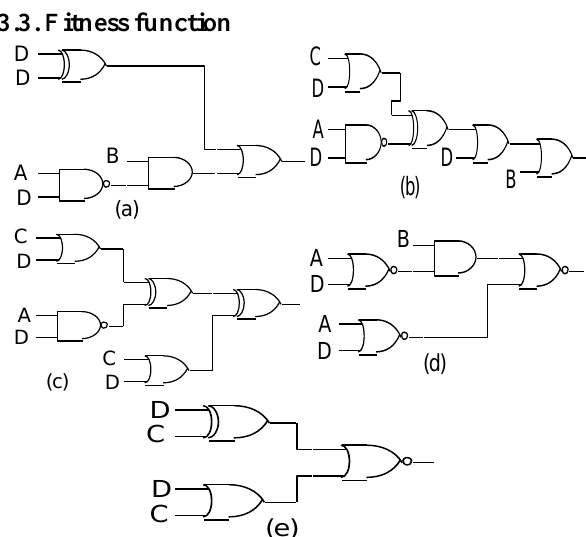
Figure 3. Equivalent circuits for array of figure 1. Last column and a) first row as output; b) second row as output; c) third row as output; d) fourth row as output; e) fifth row as